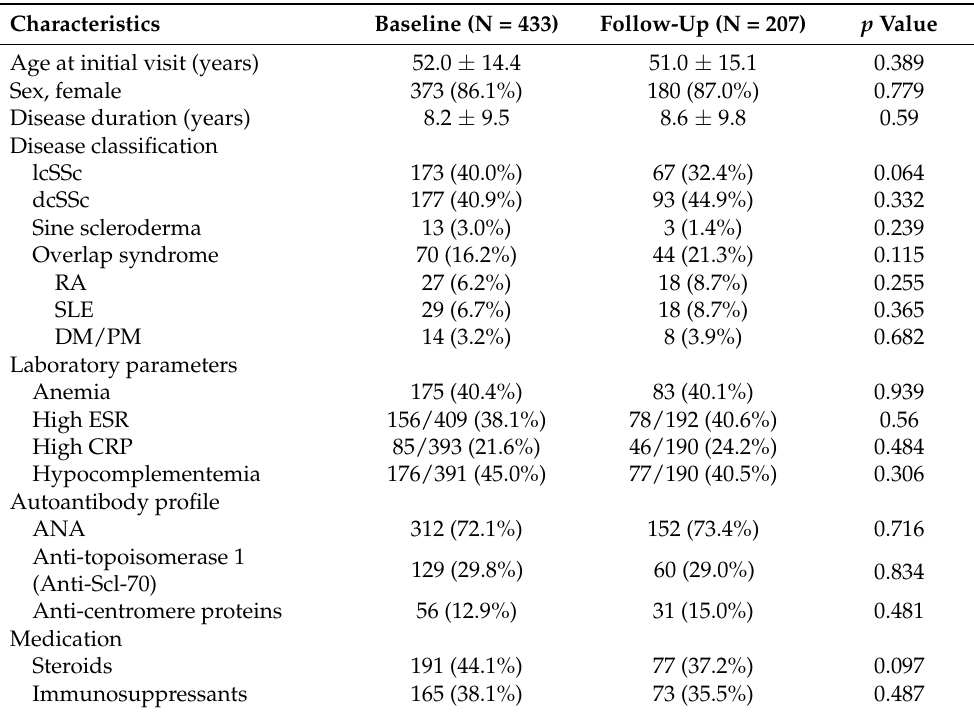
Table 1. Frequency of SCTC-DI items in SSc